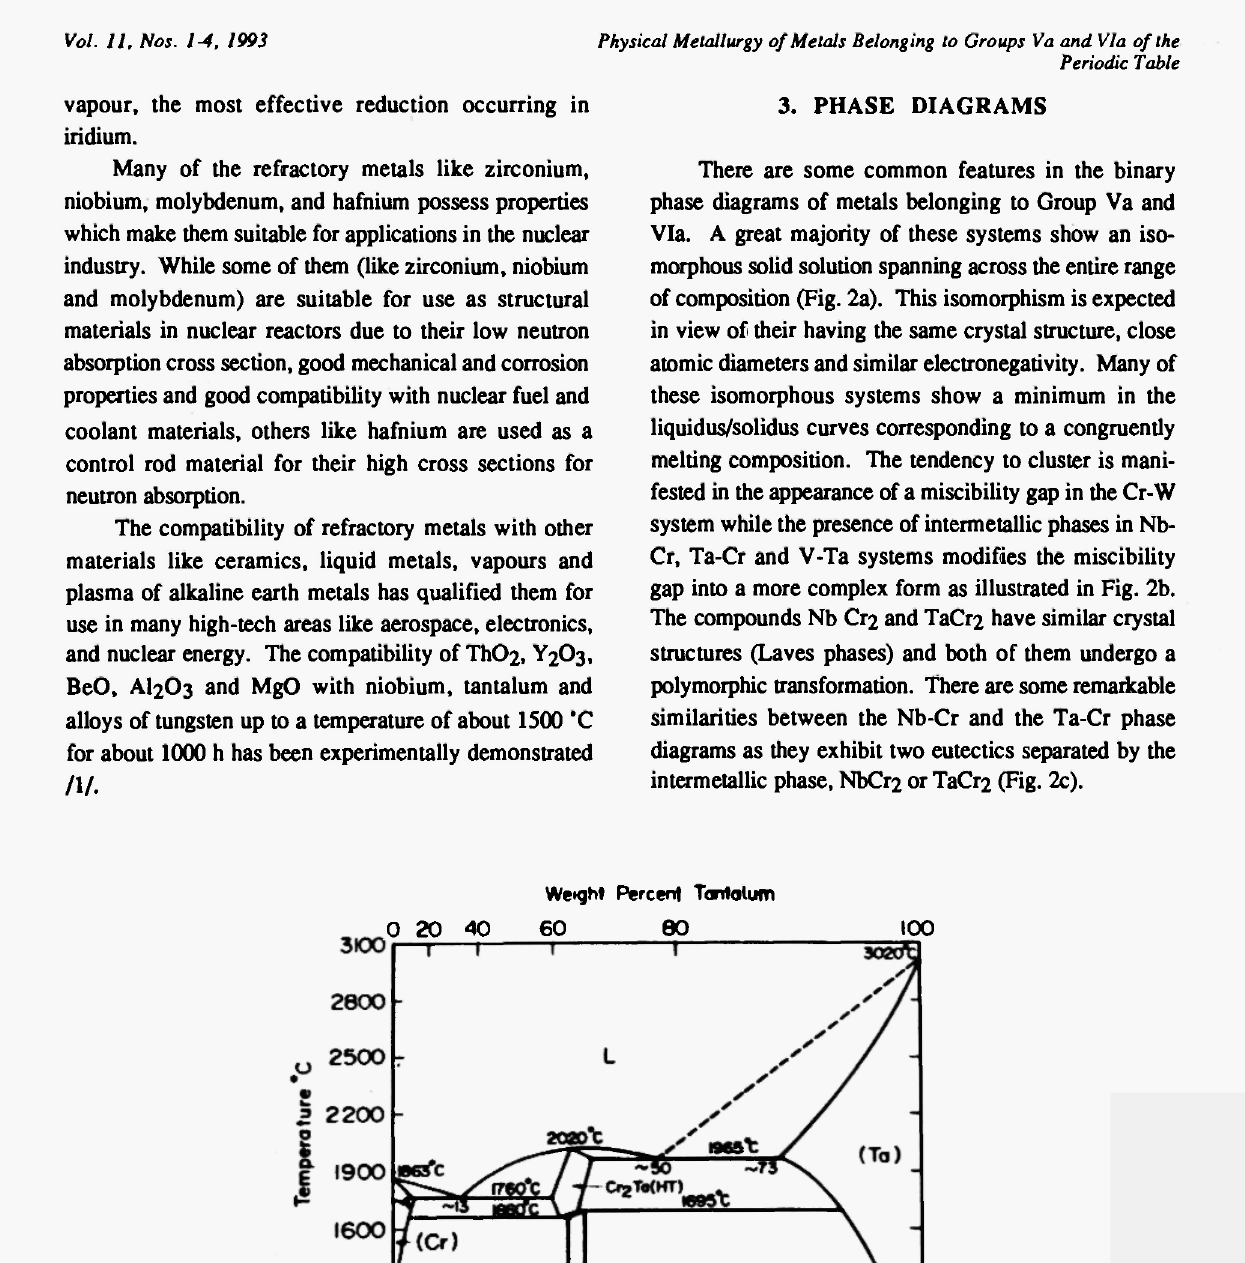
Fig. 2: (a) Phase diagram showing isomorphous solid solution in the Nb-Ta